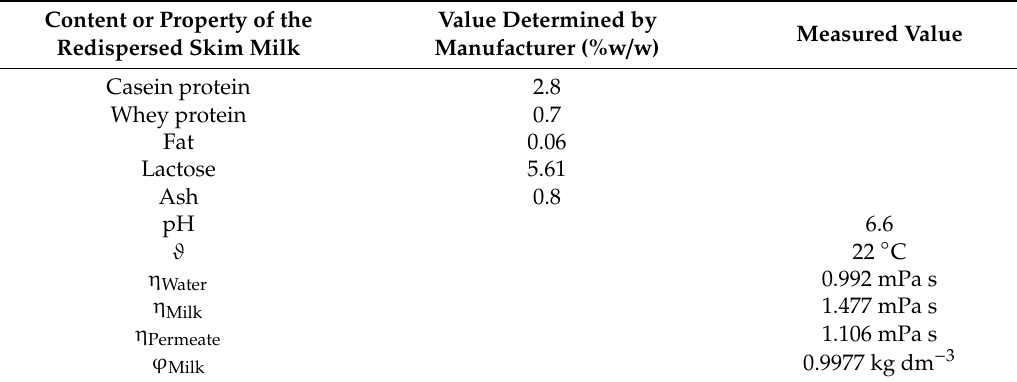
Table 1. Composition of the skim